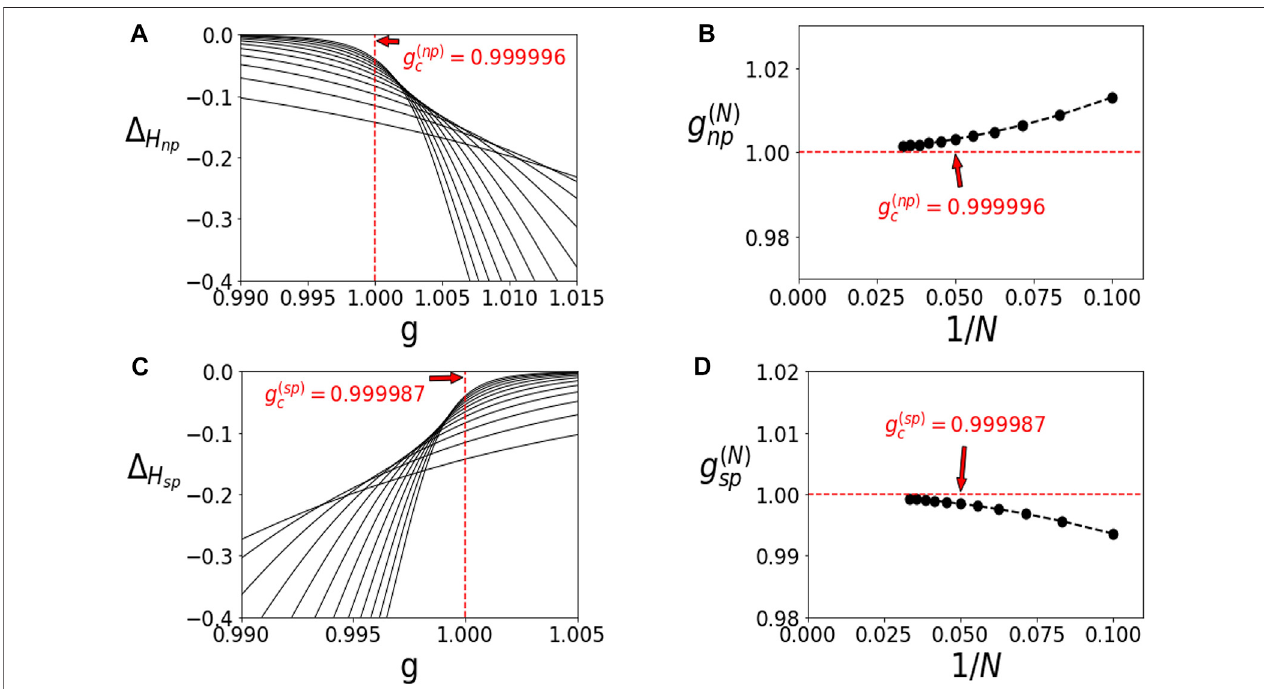
( g ; 8 , 10 ) , Δ ( g ; 10 , 12 ) , ... , Δ ( g ; 30 , 32 ) asafunction H np H np np → 0 . 999996. So, g ( np ) (cid:1) 0 . 999996. (C) c np Δ ( g ( N ) ; N − 4 , N − 2 ) (cid:1) Δ ( g ( N ) ; N − 2 , N ) , as a H sp H sp sp where sp sp